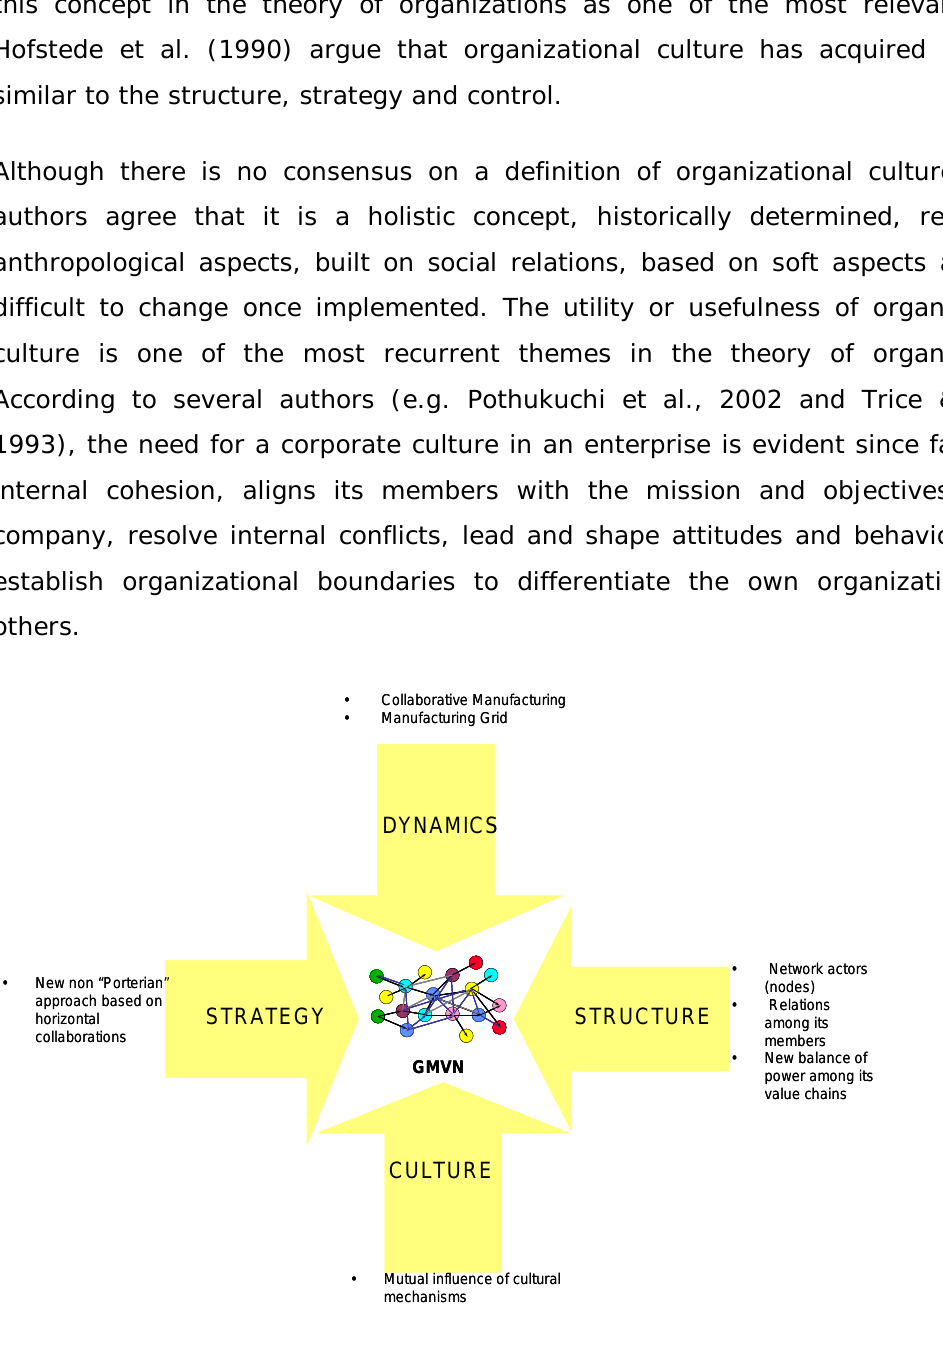
Figure 2. “Basic aspects of